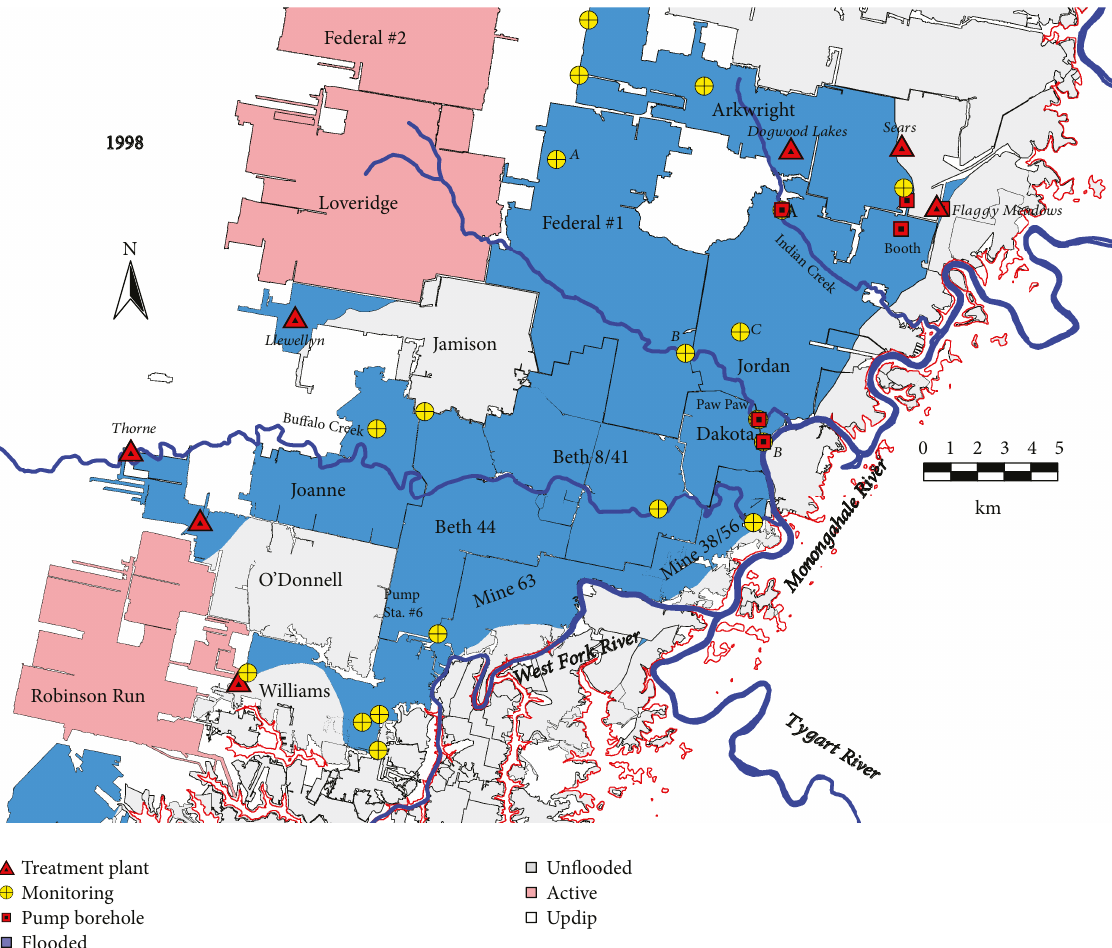
Figure 11: Flooding extent at maximum fl ooding following installation of Dakota-Jordan siphon at the Paw Paw site, 1998. Interior coal pillars are omitted for clarity. Yellow circle is Paw Paw pump; red circle is 1997 Bu ff alo Creek